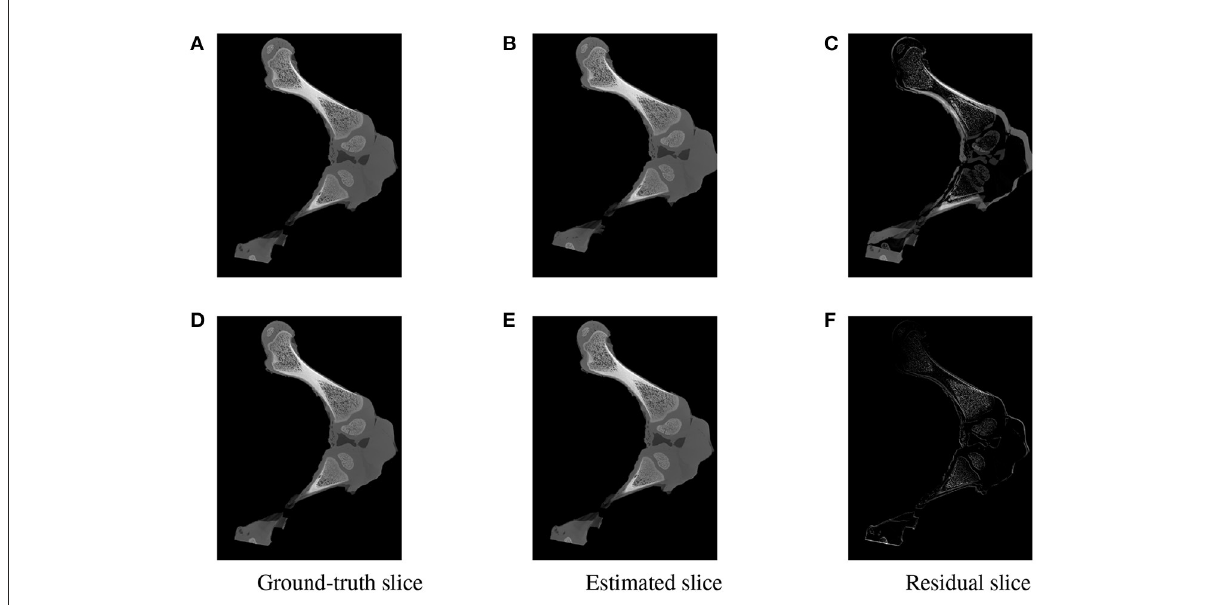
FIGURE15 Visualization of the slices extracted from the same positions in the 3D ground-truth (A,D) estimated (B,E) volumes of the two testing samples. The difference between the corresponding ground-truth and estimated slices are shown as residual images in (C,F) . The residual of the high error sample (C) is more apparent with a strong magnitude in comparison to a minor and less visible gap for the accurate registered sample (F) .